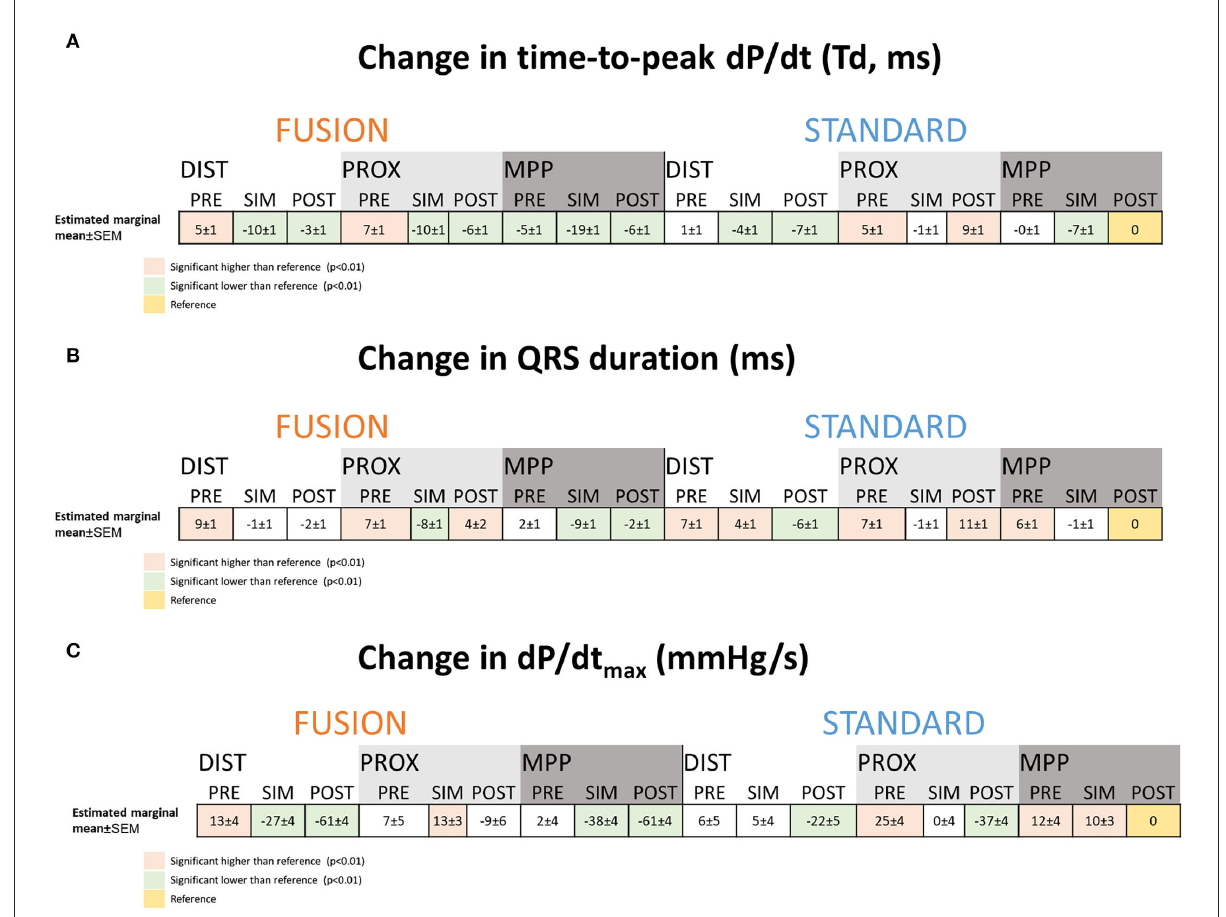
FIGURE3 Analysis of the interaction effect between mode of pacing, electrode configuration and LV pre-/postexcitation on the change in Td and QRS duration. The tables show the estimated marginal means and standard error of the linear mixed models analysis for each interaction for time-to-peak dP/dt (A) , QRS duration (B) , and dP/dt max (C) . The numbers are the estimated change from the reference selected as STANDARD*MPP*POST (marked in yellow). Colors that mark the estimates indicate a significant change compared to the reference ( p < 0.01). Numbers are estimated marginal means ± SEM. DIST, distal electrode; PROX, proximal electrode; MPP, multipoint pacing; PRE—pre-excitation of the LV between 75 and 25ms prior to QRS onset of RV pace onset; SIM— pacing the LV between 25ms before and 25ms after QRS onset or RV pace onset; POST, postexcitation of the LV 25–75ms after QRS onset or RV pace onset, Td—time-to-peak dP/dt; dP/dt, first order derivative of